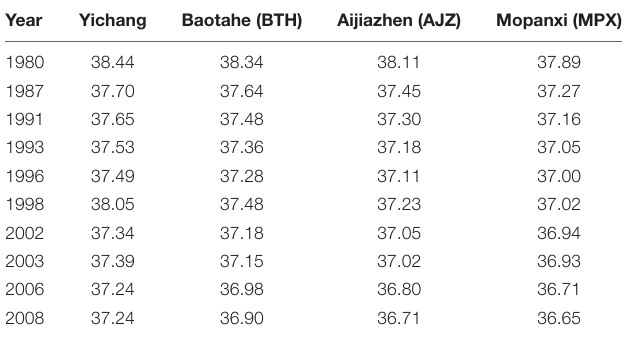
TABLE 4 | Statistics of low water levels at each water level station along the Yichang reach under the flow discharge of 5,000 m 3 /s.